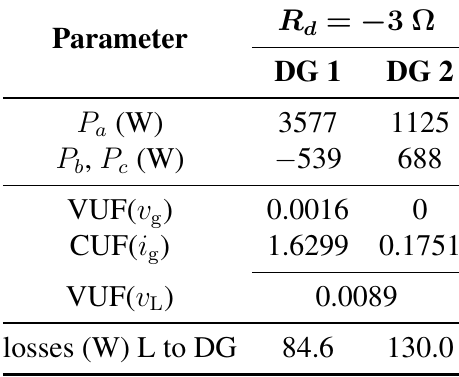
Table 10. Islanded microgrid: power sharing between two DG units with different R